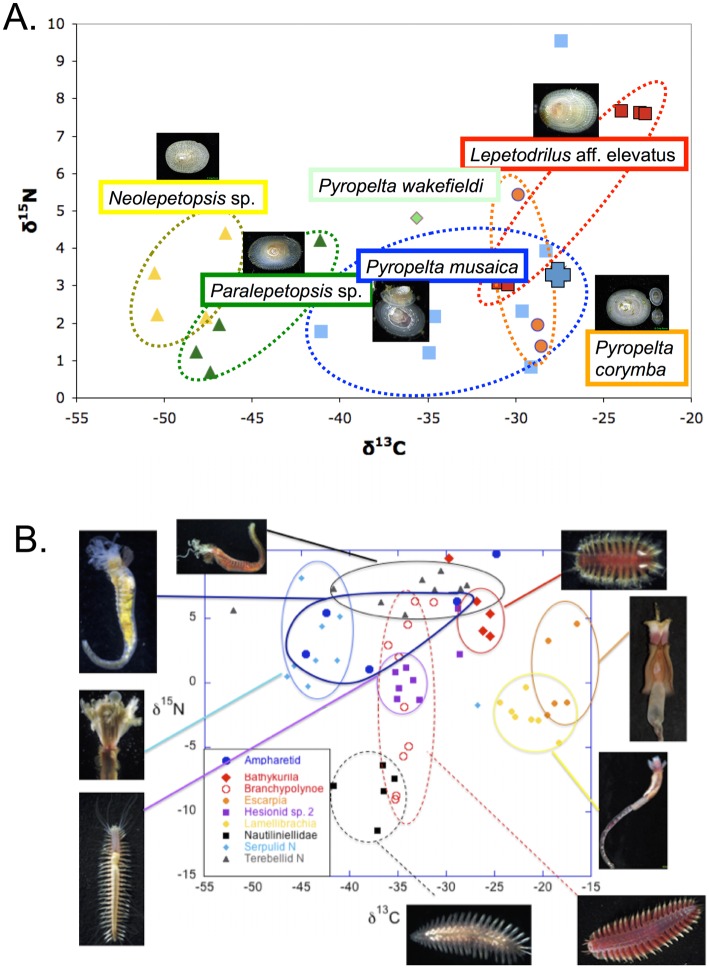
A. Dual isotope plot for polychaetes collected from carbonates on Mound 11 and 12 during AT 15–44. Costa Rica; B. Dual isotope plot for six limpet species collected on a single rock on Mound 12. In both figures each point represents a single individual.